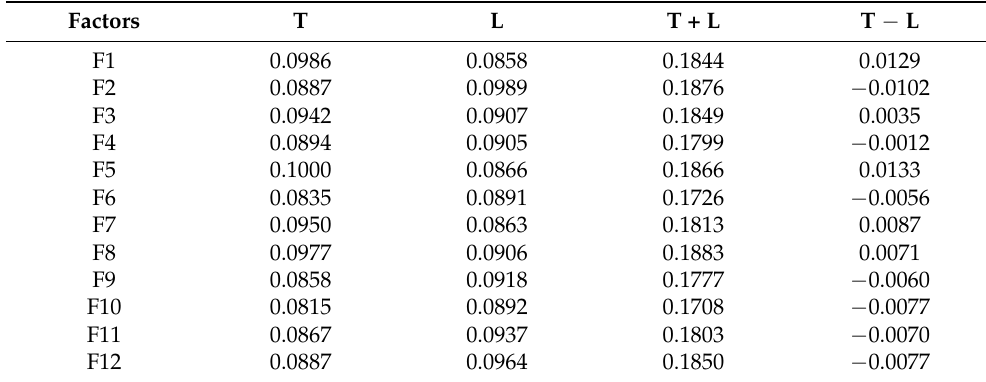
Table 14. The values calculated by